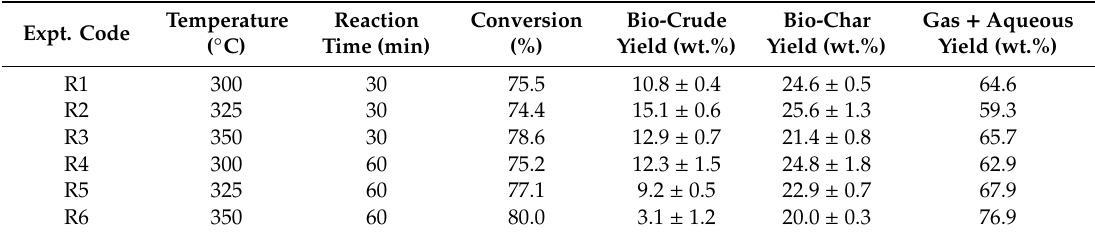
Table 2. E ff ect of final temperature and reaction time on conversion of rice straw and product yields, using water as solvent at rice-straw-to-water ratio of 1:10. Expt.